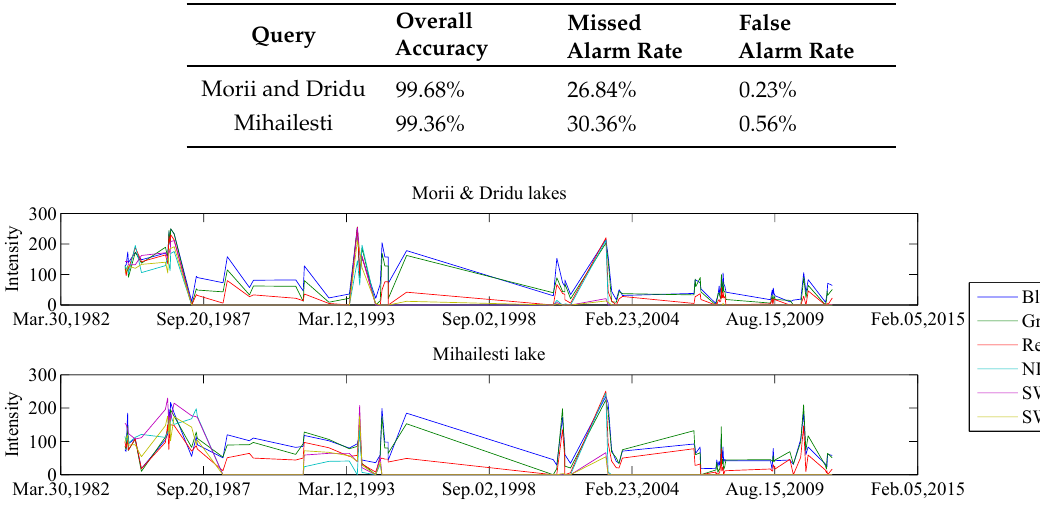
Figure 7. Spectro-temporal signatures during the construction of the accumulation lakes. The two spectro-temporal signatures are characterized by different temporal evolutions in the period that corresponds to their construction, namely